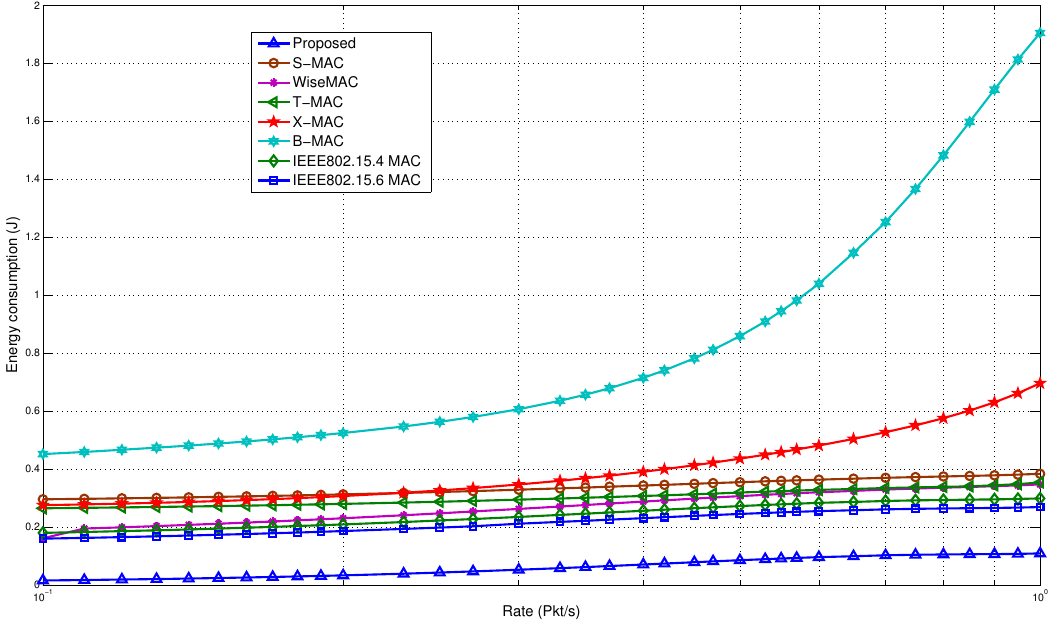
Figure 29. Impact of overhead on energy